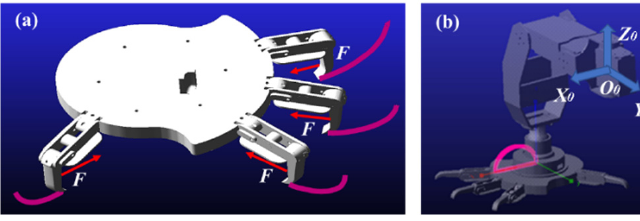
Figure 10. ( a ) Toe trajectory; ( b ) Foot trajectory. Table 2. Simulation parameters for assessing foot motion.